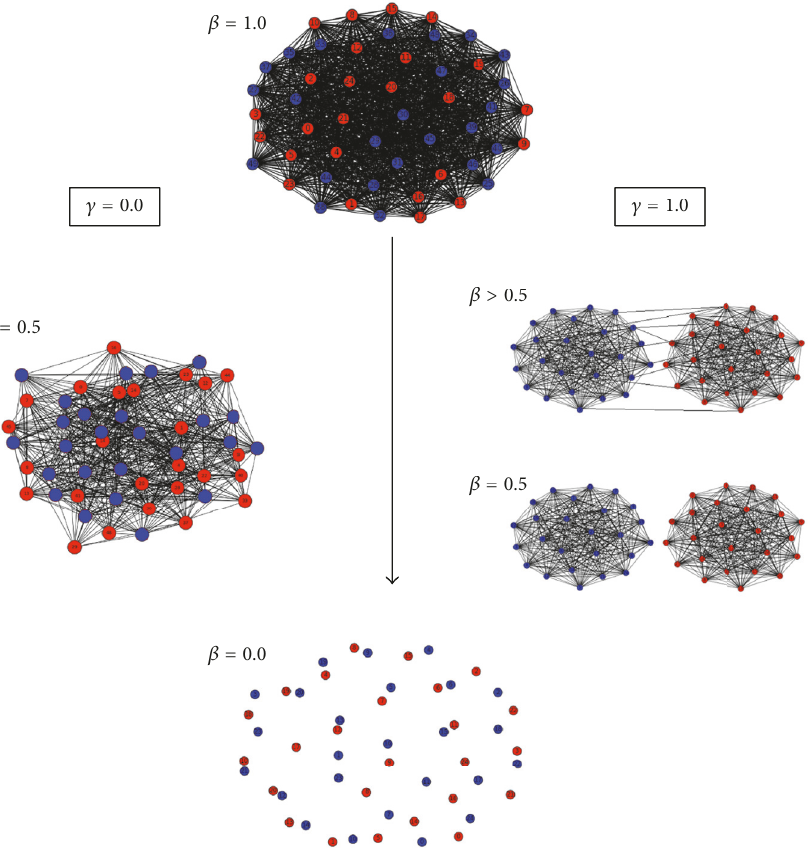
Figure 3: Pictorial representation of a continuous dilution process, via ER-L, achieved in two different ways: on the left, without any control (i.e., 𝛾 = 0 ), and on the right with maximum control (i.e., 𝛾 = 1.0 ). The arrow indicates the direction of the process, starting from the top with a complete graph, to the bottom with nonconnected nodes. Along the dilution path, the related graphs achieved by the different strategies previously described are shown. In the controlled case, the graph is split in two communities for 𝛽 ≤ 0.5 and are connected for 𝛽 > 0.5 . Different colors indicate different spin values (e.g., blue 𝜎 = +1 and red 𝜎 = −1 ).